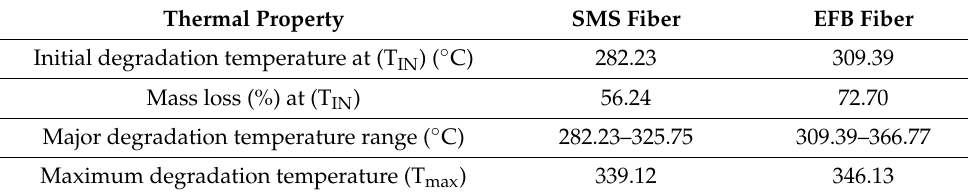
Table 1. Thermal degradation analysis of the SMS and EFB